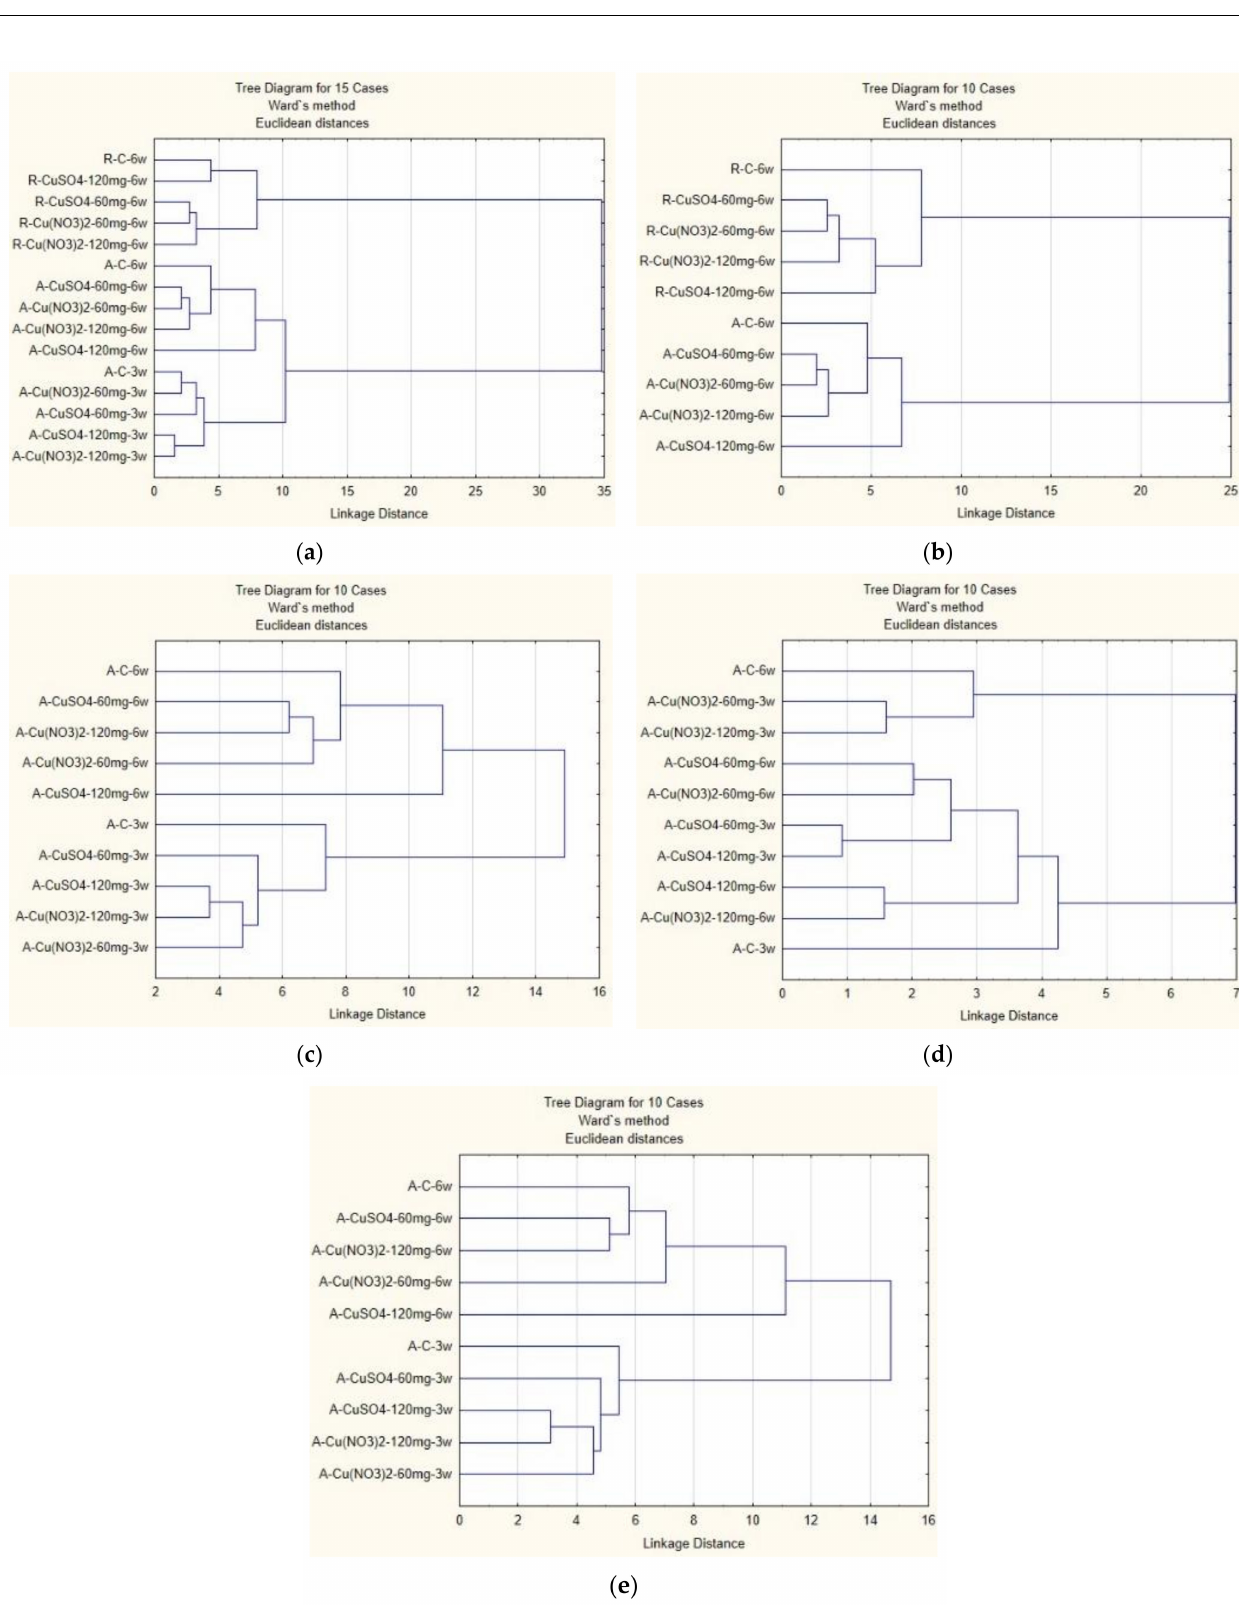
Figure 8. Hierarchical clustering dendrograms for the analysis of the chemical elements that are present both in roots and in three and six weeks aerial part ( a ), the analysis of chemical elements that are present in roots and the aerial part of six weeks only ( b ), the analysis of chemical elements and bioactive compounds aerial part ( c ), for the analysis of biological parameters, aerial part ( d ) and for the analysis of chemical elements, aerial part ( e